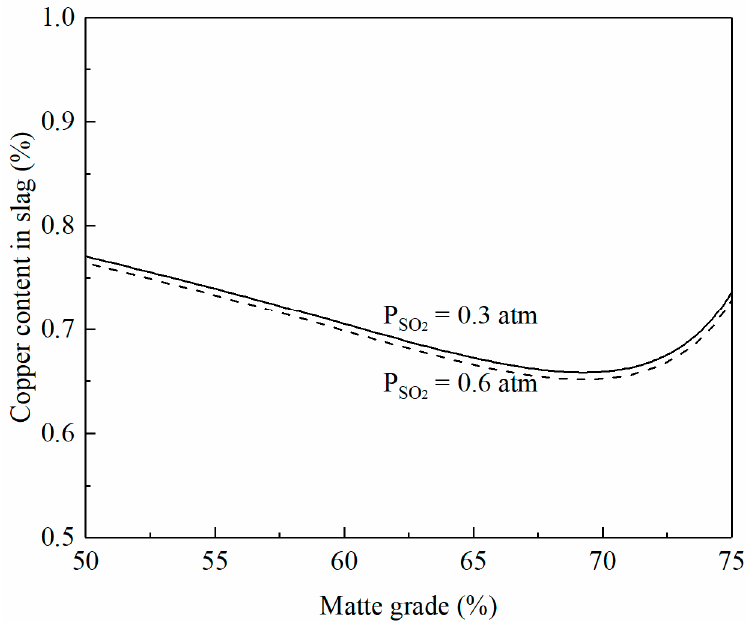
Figure 4. Effects of matte grade and SO 2 partial pressure on copper content in smelting slag at 1250 °C and Fe/SiO 2 1.3, predicted by FactSage 8.2.